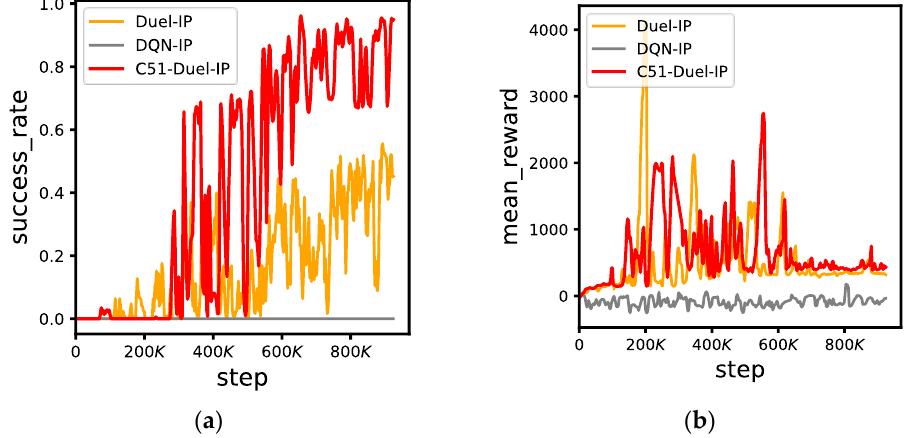
Figure 7. Scenario 2 — experimental result with independent policy: ( a ) shows the success rate, ( b ) shows the mean reward in each episode.